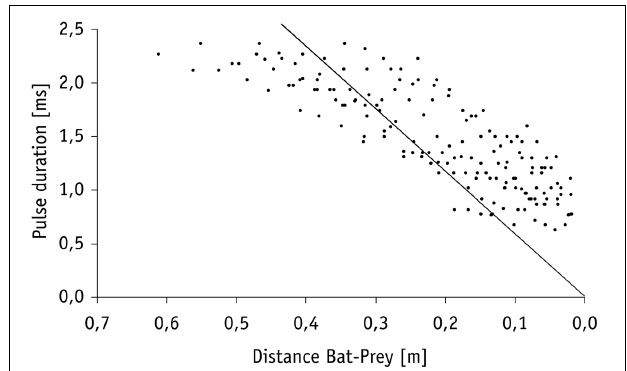
FIGURE 4 | Decrease in pulse duration of terminal phase calls from nine individuals of M. macrophyllum while approaching potential food floating on the water surface of Gatún Lake near the shore of BCI, Panamá. The solid line indicates the limit beyond which calls overlap with returning echo from